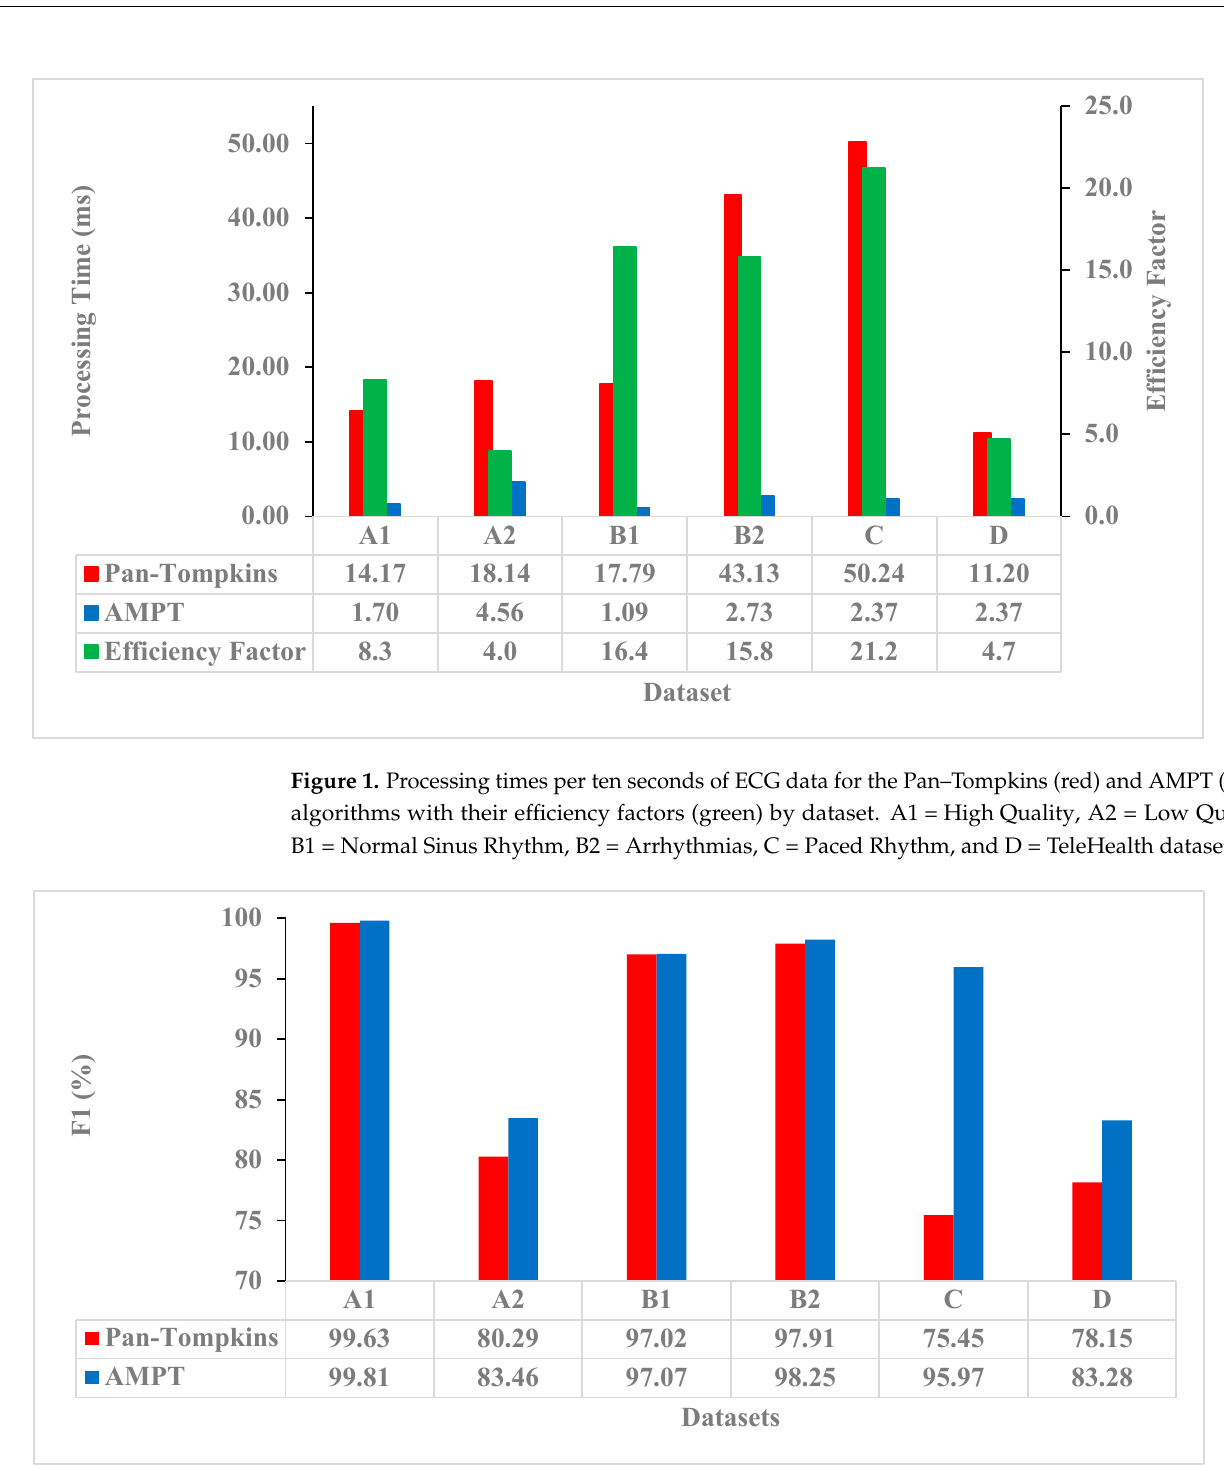
Figure 2. F1 correctness for the Pan–Tompkins (red) and AMPT (blue) algorithms by dataset. A1 = High Quality, A2 = Low Quality, B1 = Normal Sinus Rhythm, B2 = Arrhythmias, C = Paced Rhythm, and D = TeleHealth